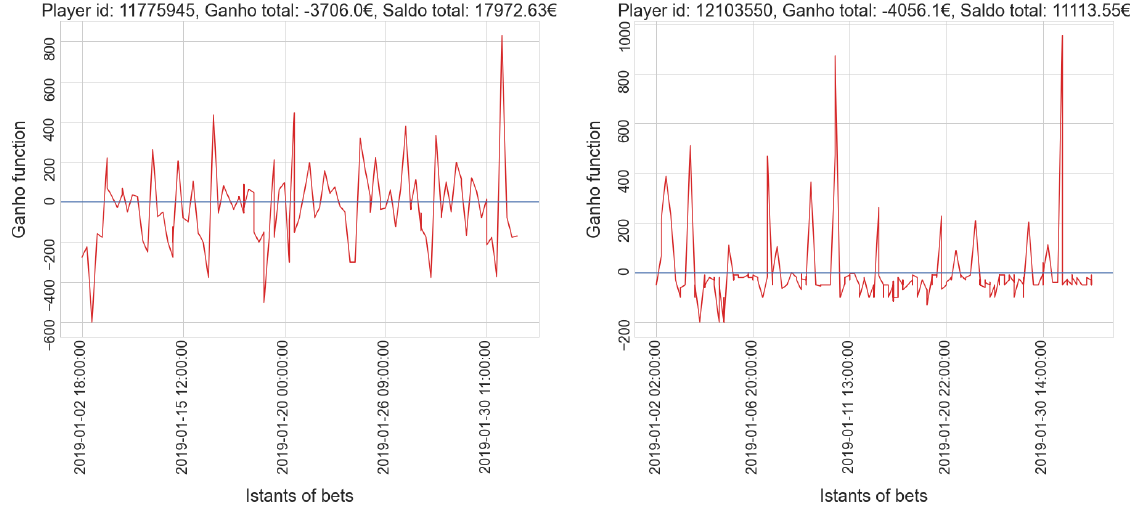
Figure 7. Time series plot of two players in Cluster 0.